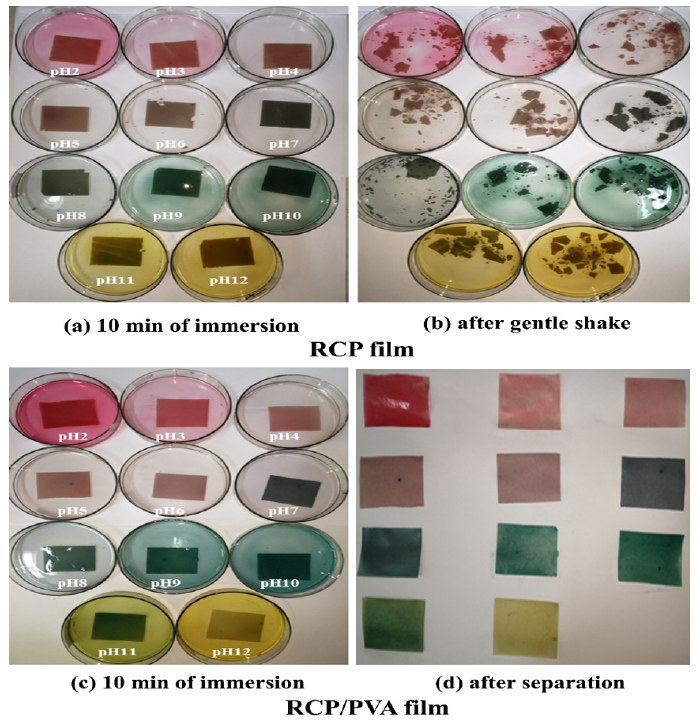
Figure 6. Colorimetric response of RCP and RCP/PVA films immersed in different pH buffer solutions (pH of 2–12).